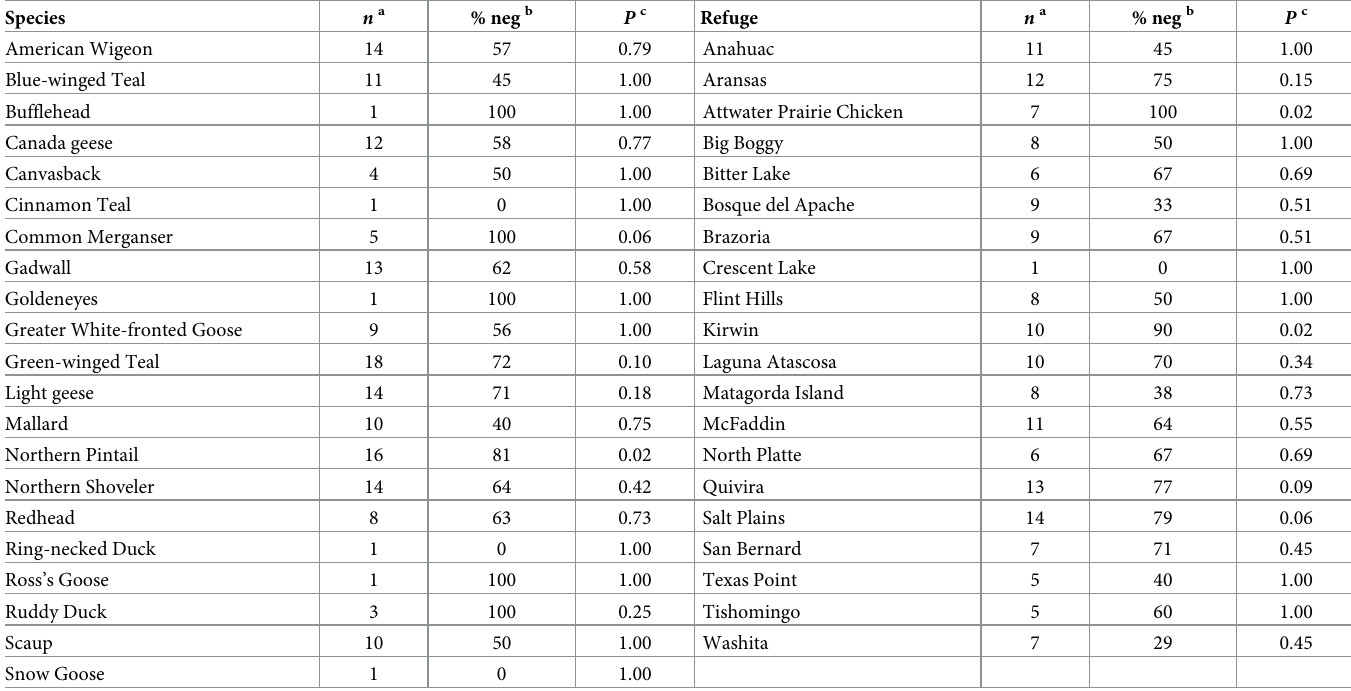
Table 3. Skewness in the distribution of slopes indicating advancements or delays in spring peak with increasing temperature by waterfowl species and refuge. Species n a % neg